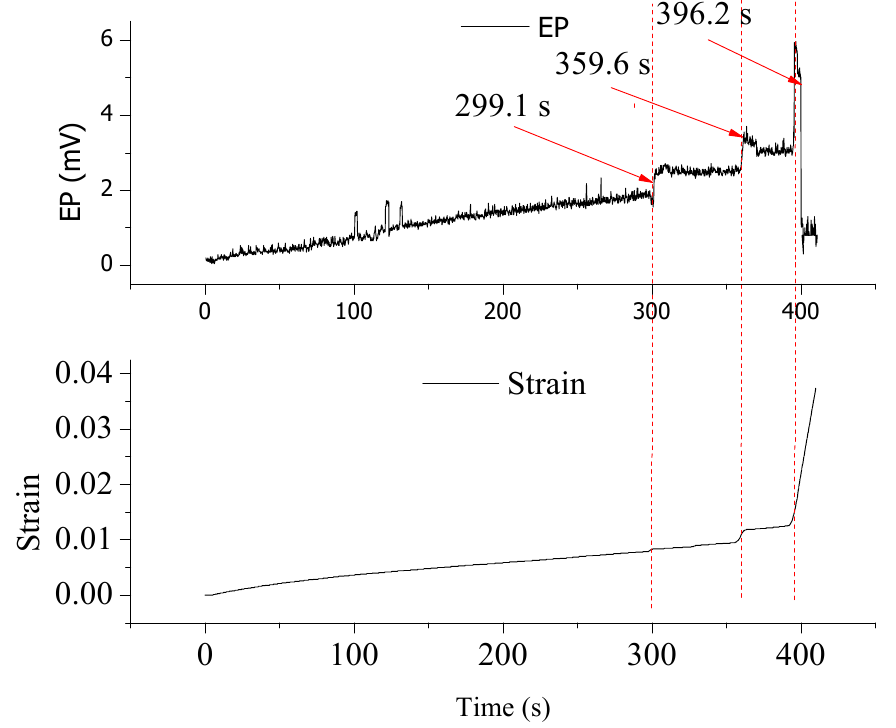
Figure 8. Curves of strain and EP with respect to loading time.